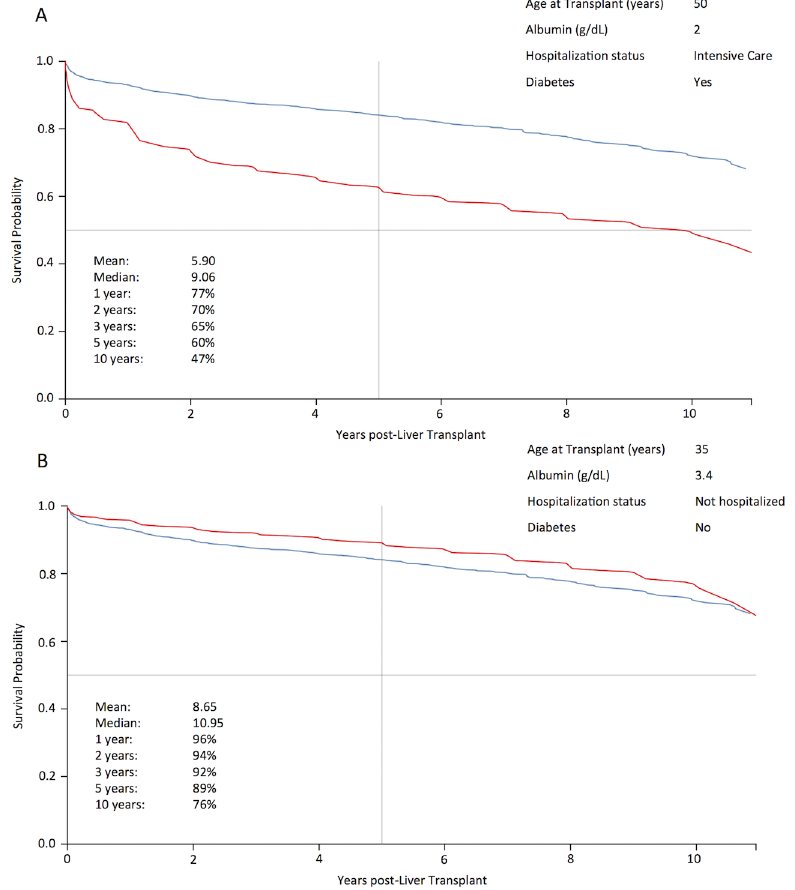
Fig 5. Two examples of predicted individual survival curve (in red) generated by the calculator. The blue curve corresponds to the Kaplan-Meier survival curve for the entire population used to learn the model (2769 patients). Of note, a vertical bar representing 5-years post-transplant survival shows a survival probability of 60% for the first patient (which should raise the question of the utility of such a transplant), and of 89% for the second patient, which is excellent in comparison to most indications for